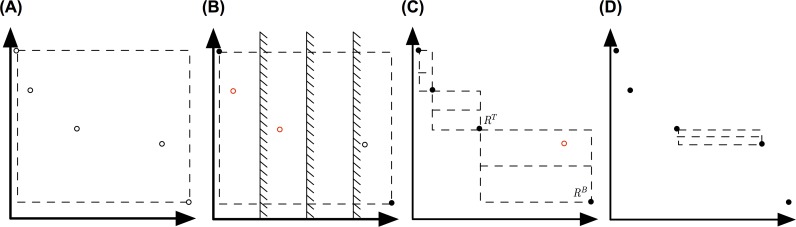
Depiction of the parallel two-phase rectangle splitting approach.(A) First, the boundaries of the Pareto front are identified. (B) Then, the space between the boundaries is evenly divided and searched in parallel for nondominated points using the ε-constraint method. (C) The identified nondominated points are used to initiate rectangle search spaces which can be processed in parallel using the standard rectangle-splitting approach, by splitting the rectangle in half and searching independently the bottom and top half (D). If the corner points of the rectangles are found during the search, it is proofs, that no further nondominated point resides within the search space and all points have been identified.